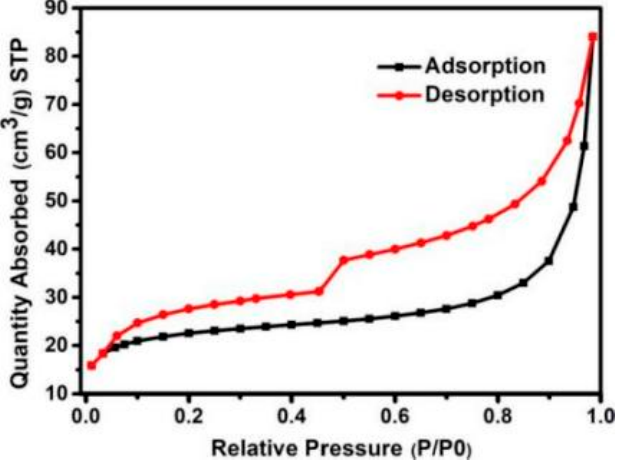
Figure 18. The nitrogen adsorption/desorption isotherm of BiVO 4 /13.0 wt.% RGO hybrid [122].